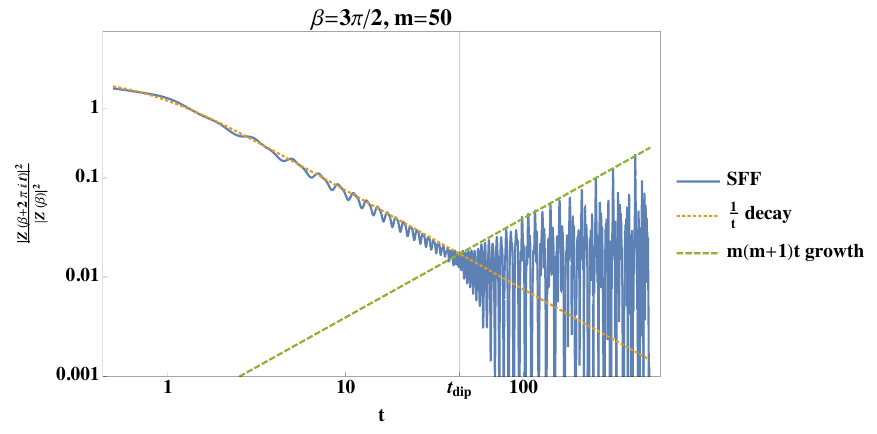
without any averaging. The dip and ramp 2